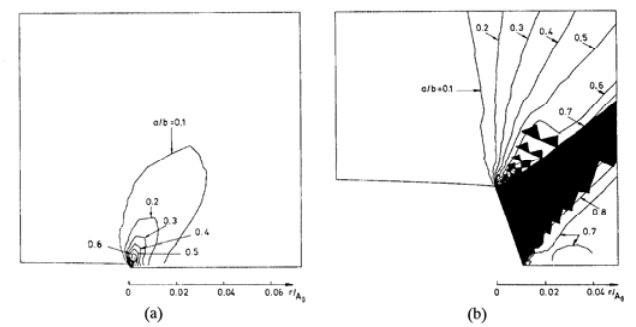
Figure 2: Distributions of creep damage ahead of a crack-tip. Continuous cavity nucleation, no grain boundary sliding, and 40 C = . (a) . (From [18]). Plane strain multi-grain cell models for a polycrystal- line aggregate have been used by van der Giessen and Tvergaard [19] to study the final creep fracture process, as microcracks formed at grain boundary facets link